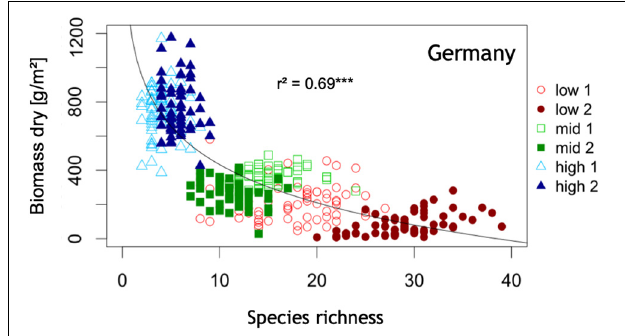
FIGURE 4 | Plant species richness as a function above ground biomass production: Highest community plant species richness is associated with lowest community productivity at this half of the productivity gradient. Low = site of low productivity, mid = sites of intermediate productivity, high = sites of high productivity. Data shown here are based on 364 plots of 1 m × 1 m area organized in six systematic grids across a local productivity gradient in mesic temperate grassland close to Bayreuth University in Germany, part of the Herbaceous Diversity Network HERBDIVNET (see details in Fraser et al., 2015). *** p < 0.001.